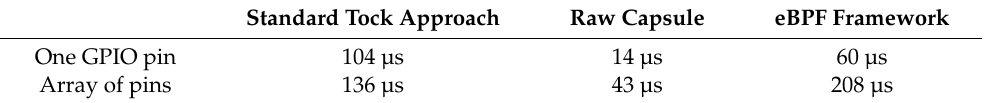
Table 3. Comparison between delays obtained in handling interrupts.